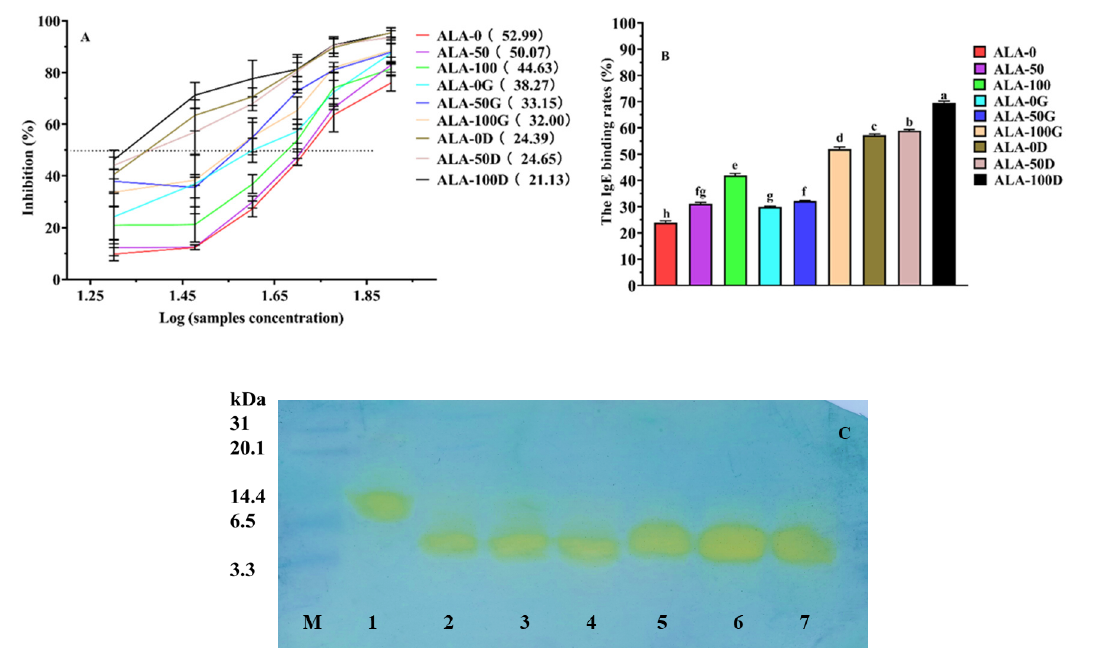
Figure 2. The IgG ( A ) and IgE ( B ) binding abilities of ALA treated by ultrasound during in ‐ vitro gastric and gastroduodenal digestion determined by icELISA. Rabbit anti ‐ ALA IgG was incubated separately with 20, 30, 40, 50, 60, 80 μ g/mL substrate samples, gastric and gastroduodenal digesta. Letters (a–g) demonstrate significant differences ( p < 0.05). Western blotting pattern ( C ) of ALA ‐ 0 (Lane 1), ALA ‐ 0G (Lane 2), ALA ‐ 50G (Lane 3), ALA ‐ 100G (Lane 4), ALA ‐ 0D (Lane 5), ALA ‐ 50D (Lane 6), and ALA ‐ 100D (Lane 7). The molecule weight distribution of marker (M) ranges from 3.3 to 31 kDa. IgG: immunoglobulin G, IgE: immunoglobulin E. ALA ‐ 0: untreated ALA, ALA ‐ 50: ultrasound ‐ treated ALA at 50 W/cm 2 , ALA ‐ 100: ultrasound ‐ treated ALA at 100 W/cm 2 . ALA ‐ 0G, ALA ‐ 50G, and ALA ‐ 100G: ALA ‐ 0, ALA ‐ 50, and ALA ‐ 100 digested by simulated gastric juice. ALA ‐ 0D, ALA ‐ 50D, and ALA ‐ 100D: ALA ‐ 0, ALA ‐ 50, and ALA ‐ 100 digested by simulated gastric juice followed simulated duodenal juice.